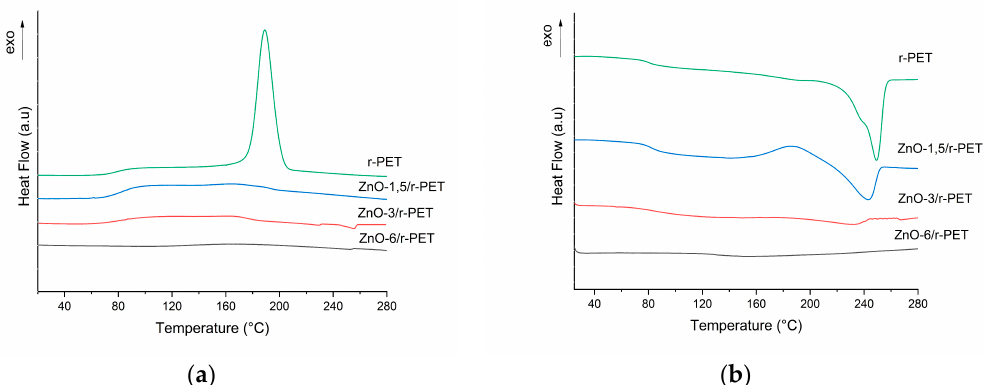
Figure 3. ( a ) Cooling stage thermogram and ( b ) second heating stage thermograms of r-PET composite fibers.